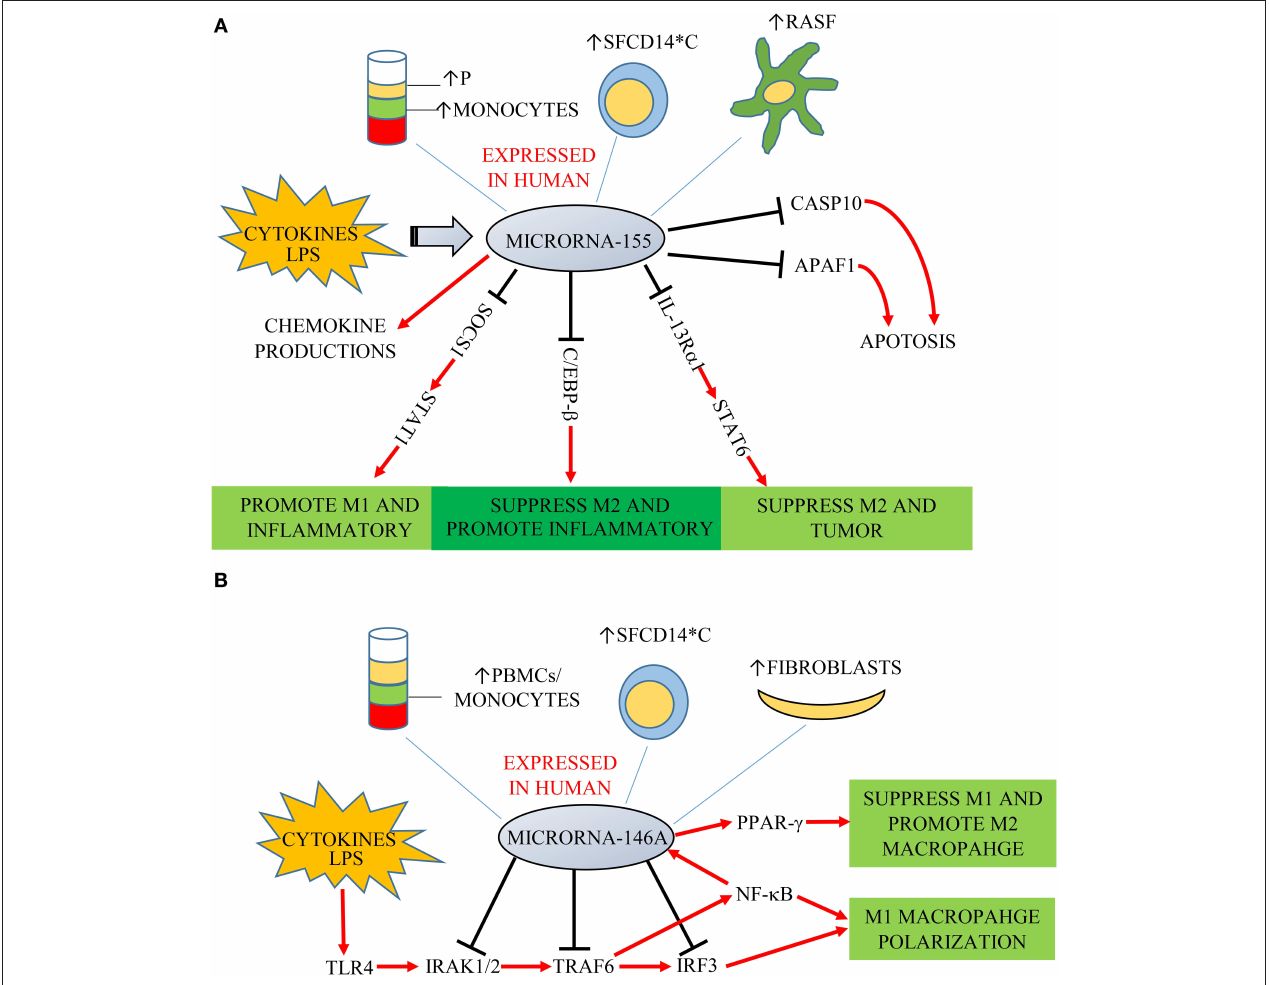
FIGURE 1 | (A) MiR-155 is expressed in plasma (P), monocytes, fibroblast-like synoviocytes (RASF) and synovial fluid monocytes (SFCD14*C) of patients with RA/JIA. It is induced by cytokines and LPS, and overexpression increases chemokine production. SOCS1, IL-13R α 1, and C/EBP- β are key target genes of miR-155. SOCS1 is a negative regulator of STAT1. MiR-155 decreased SOCS1 expression, increasing signaling through STAT1 to promote M1 macrophages and suppress M2 macrophages to promote inflammatory responses. MiR-155 could also directly target C/EBP- β to suppress M2 macrophages. MiR-155 directly targets IL-13R α 1 and decreases the levels of IL-13Ra protein, resulting in decreased activation of the M2-promiting STAT6. MiR-155 is also associated with decreased expression of two predicated miR targets that mediate apoptosis: CASP10 and APAF1. (B) MiR-146a was expressed in PMBCs, monocytes, synovial fibroblasts, and synovial fluid monocytes (SFCD14*C) of patients in RA/JIA. It is induced by cytokines and LPS through the NF- κ B pathway. It controls TLR4 signaling through a regulatory loop: the upregulation of miR-146a by caused by activated NF- κ B; miR-146a reduces the expression of its targets including TRAF6, IRAK1, IRAK2, and IRF3; which limits activity of both NF- κ B and IRF3